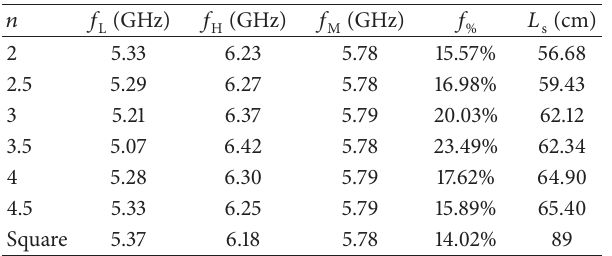
Table 2: Details of different